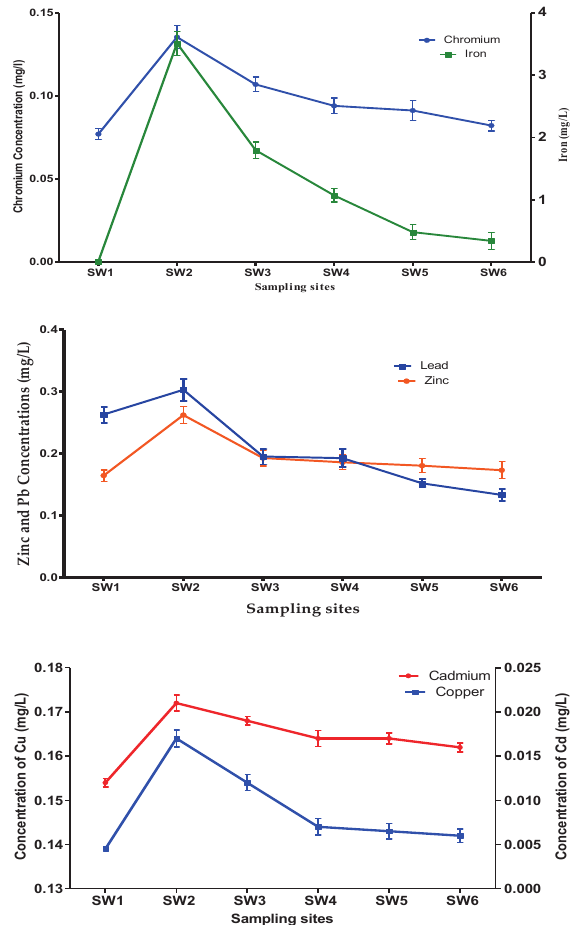
Figure 6 Figure 6: Average concentrations of (a) Chromium and Iron (b) Lead and Zinc (c) Cadmium and Copper in the leachate and surface water samples taken at the different sampling sites along Ndawuse River during the study